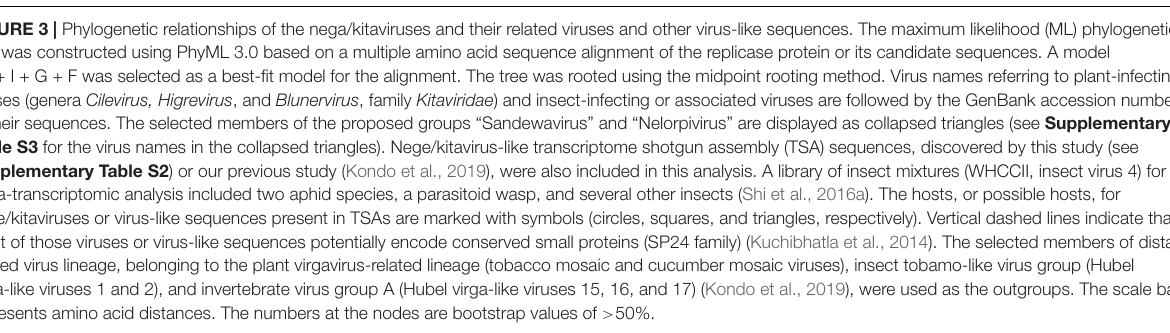
FIGURE 3 | Phylogenetic relationships of the nega/kitaviruses and their related viruses and other virus-like sequences. The maximum likelihood (ML) phylogenetic tree was constructed using PhyML 3.0 based on a multiple amino acid sequence alignment of the replicase protein or its candidate sequences. A model LG + I + G + F was selected as a best-fit model for the alignment. The tree was rooted using the midpoint rooting method. Virus names referring to plant-infecting viruses (genera Cilevirus, Higrevirus , and Blunervirus , family Kitaviridae ) and insect-infecting or associated viruses are followed by the GenBank accession numbers of their sequences. The selected members of the proposed groups “Sandewavirus” and “Nelorpivirus” are displayed as collapsed triangles (see Supplementary Table S3 for the virus names in the collapsed triangles). Nege/kitavirus-like transcriptome shotgun assembly (TSA) sequences, discovered by this study (see Supplementary Table S2 ) or our previous study (Kondo et al., 2019), were also included in this analysis. A library of insect mixtures (WHCCII, insect virus 4) for the meta-transcriptomic analysis included two aphid species, a parasitoid wasp, and several other insects (Shi et al., 2016a). The hosts, or possible hosts, for nege/kitaviruses or virus-like sequences present in TSAs are marked with symbols (circles, squares, and triangles, respectively). Vertical dashed lines indicate that most of those viruses or virus-like sequences potentially encode conserved small proteins (SP24 family) (Kuchibhatla et al., 2014). The selected members of distantly related virus lineage, belonging to the plant virgavirus-related lineage (tobacco mosaic and cucumber mosaic viruses), insect tobamo-like virus group (Hubel virga-like viruses 1 and 2), and invertebrate virus group A (Hubel virga-like viruses 15, 16, and 17) (Kondo et al., 2019), were used as the outgroups. The scale bar represents amino acid distances. The numbers at the nodes are bootstrap values of >